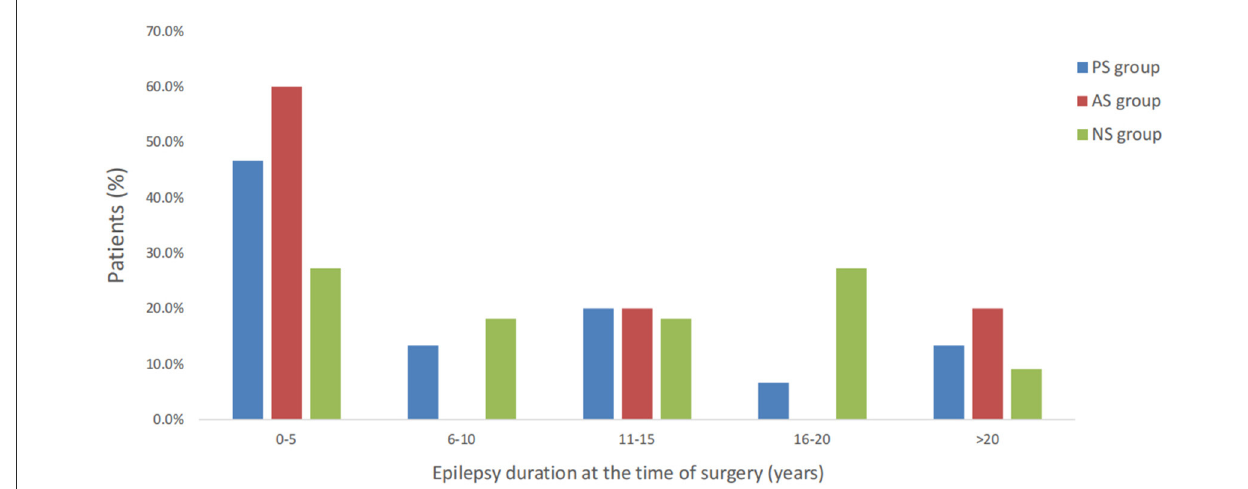
FIGURE1 Distribution of epilepsy duration at the time of surgery was similar during three different groups.